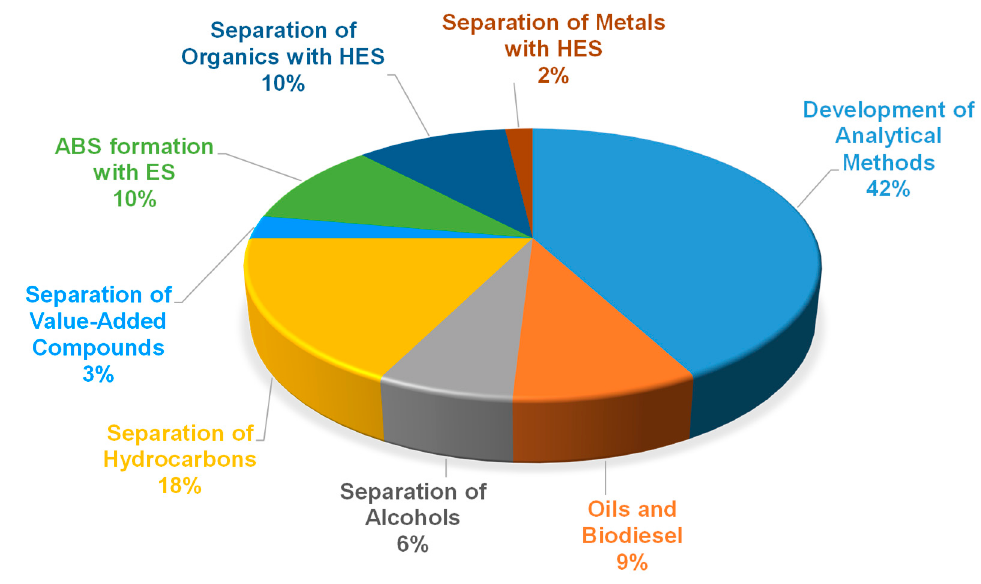
Figure 3. Percentage distribution of the 217 published papers (2007–2020) on eutectic solvents (ES) in liquid–liquid extraction as a function of the application.